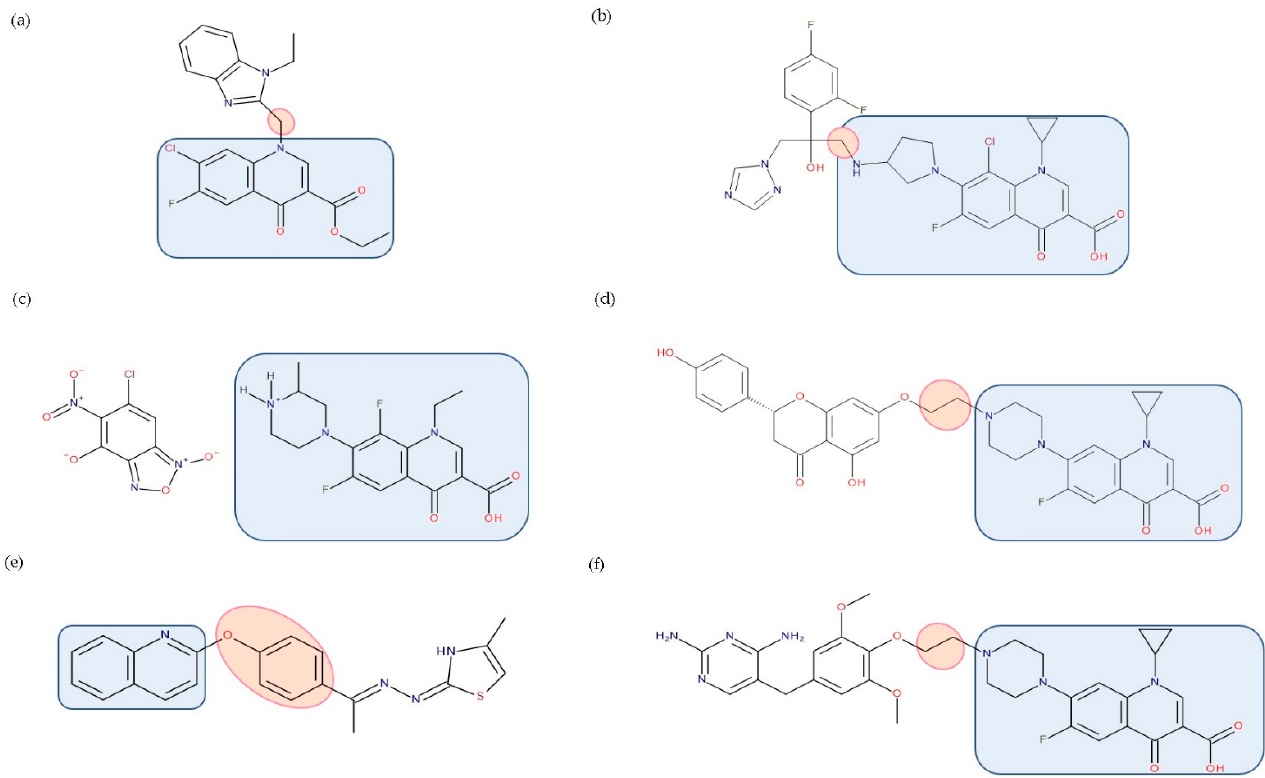
Figure 14. Examples of antibiotic–non-antibiotic hybrids containing an FQN; the linker is high- lighted with the orange circle while the QN/FQN unit is highlighted by the blue rectangle: ( a ) benzimidazole derivative–linker–quinolone derivative (esther form) [219]; ( b ) triazole derivative– linker–clinafloxacin [286]; ( c ) benzofuroxan derivative–lomefloxacin [217]; ( d ) naringenin–linker– ciprofloxacin [207,273]; ( e ) thiazole derivative–linker–quinolone [287]; ( f ) trimethoprim–linker– ciprofloxacin [207,277].